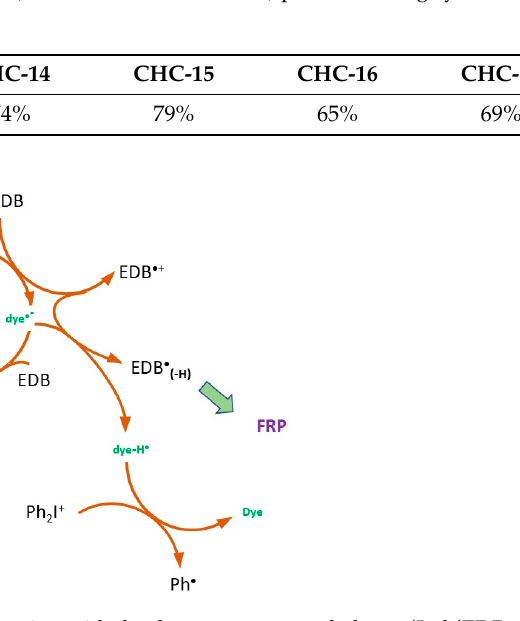
Figure 14. Photochemical mechanism occurring with the three-component chalcone/Iod/EDB sys- tem.